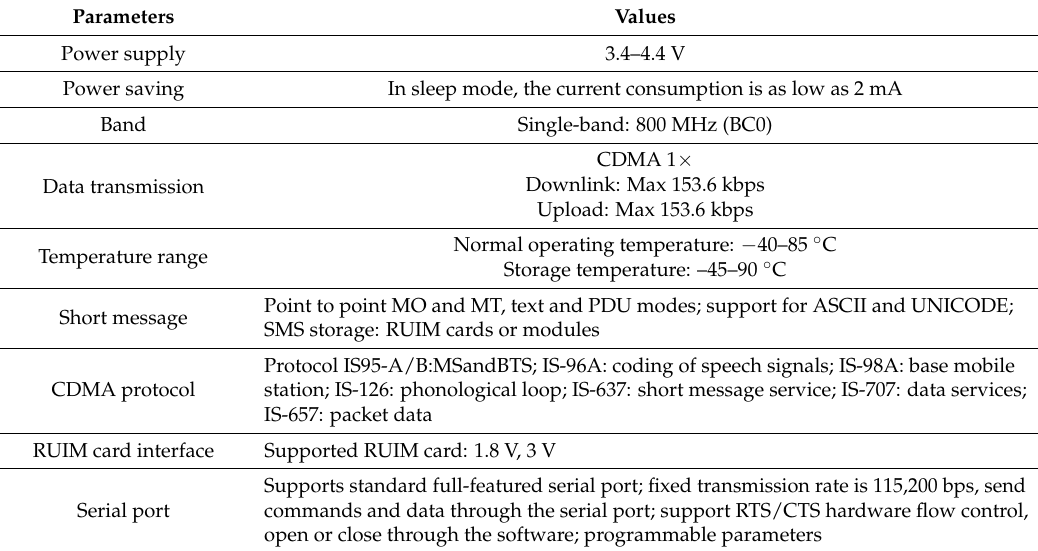
Table 4. Parameters of SIM2000C.